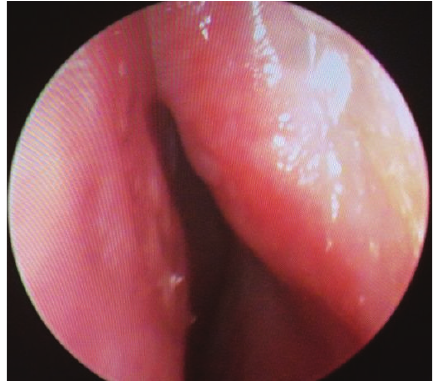
Figure 4: Normal physical examination was seen after 4 months